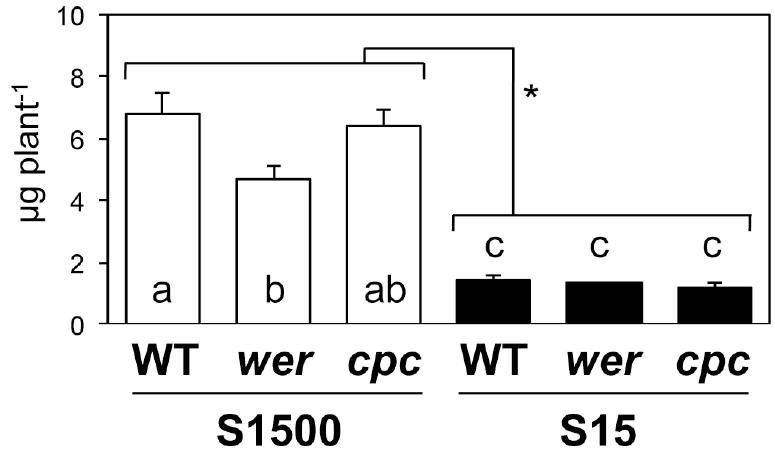
Figure 6. Sum of sulfur levels in shoots of WT, wer , and cpc mutants grown under S1500 and S15 conditions. Plants were vertically grown for 10 d on S1500 (white bars) and S15 (black bars) agar media. Sulfate, Cys, GSH, and sulfur contents in precipitate of shoot tissues were calculated to µg sulfur per plant. The values and error bars indicate means ± SEM (n = 3). As two-way ANOVA detected the interaction between sulfur conditions and genotypes, the Tukey–Kramer test was applied to all six experimental conditions. Different letters mean significant differences ( P < 0.05). Asterisks indicate significant differences between S1500 and S15 conditions (2-way ANOVA; * P < 0.05) .